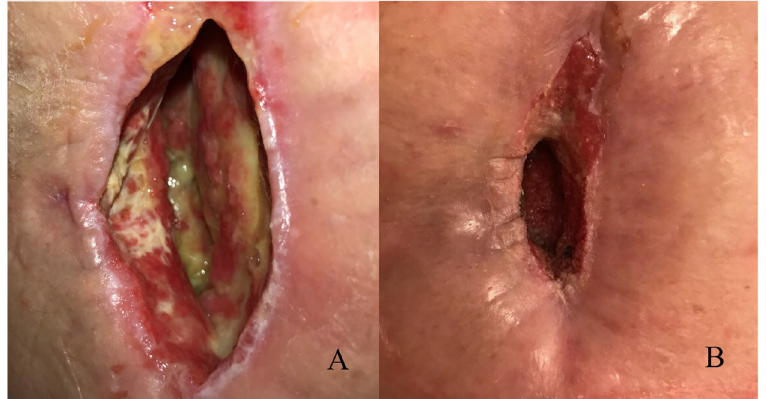
Fig 1. Pictures of a patient referred from our medical center for a chronic wound of the medial upper leg after limb-salvage therapy, consisting of surgery and preoperative radiotherapy. A, At HBOT initiation, 11 weeks after completion of limb-salvage therapy. B, Improved wound healing is seen after 40 sessions of